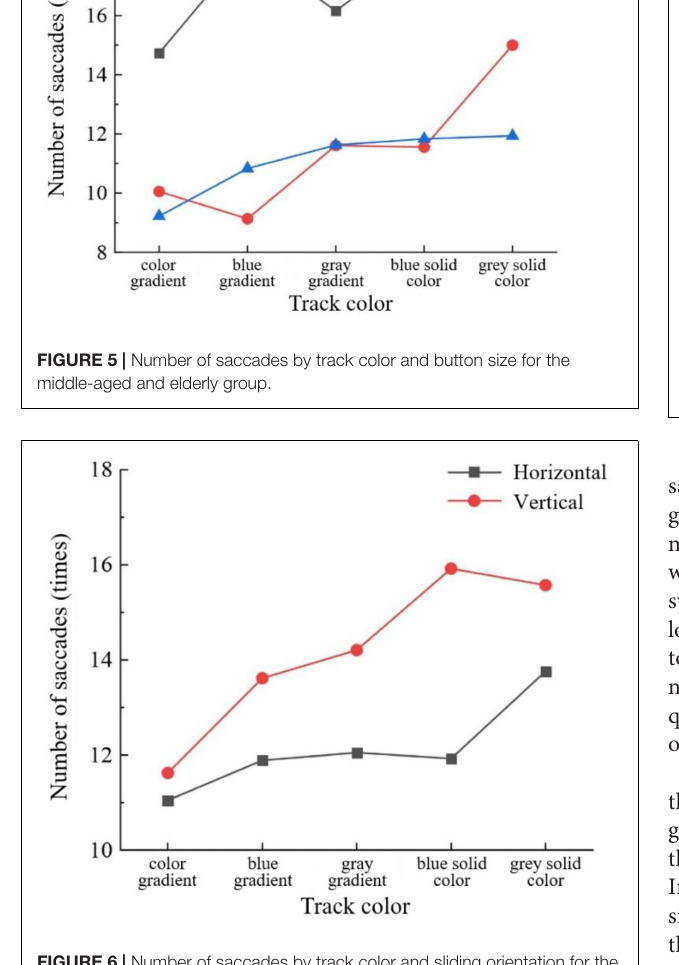
FIGURE 6 | Number of saccades by track color and sliding orientation for the middle-aged and elderly group.